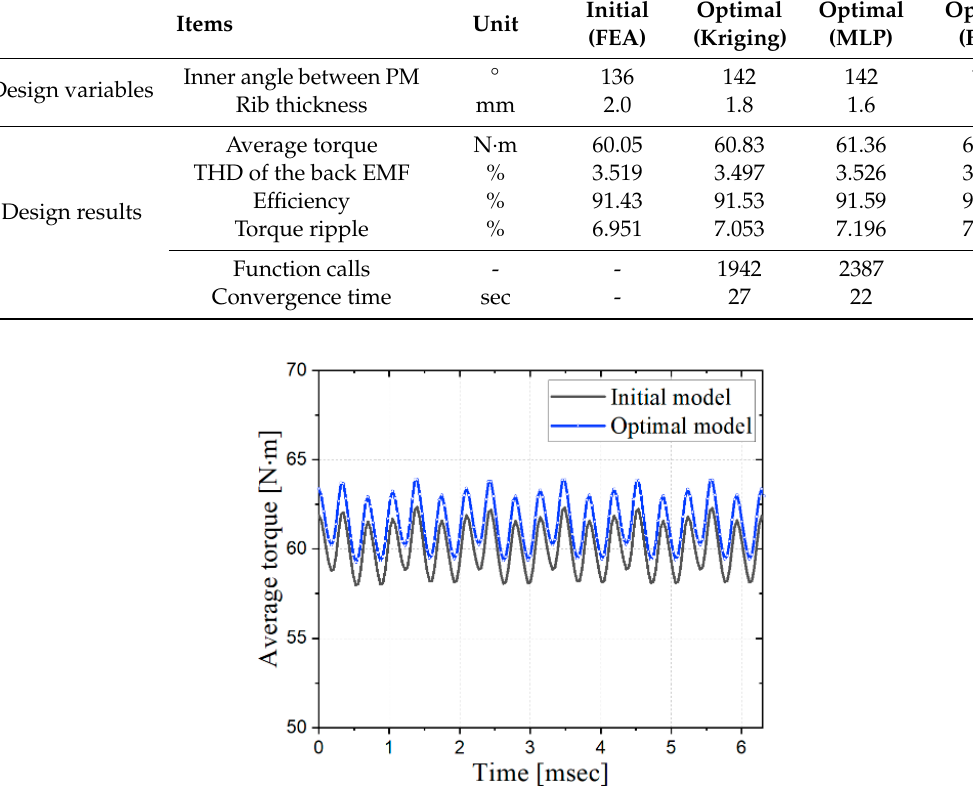
Table 3. Optimization results.